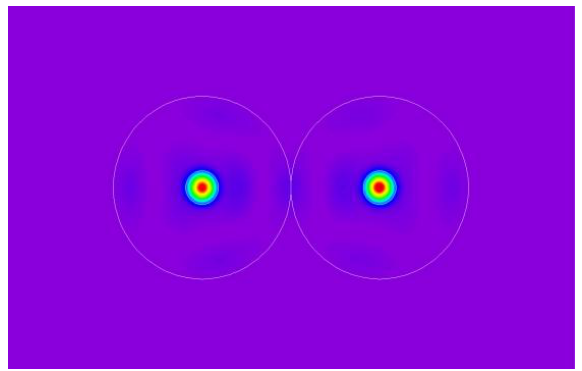
Figure 15. 2D power distribution map ( z = 4955.3991 μm).